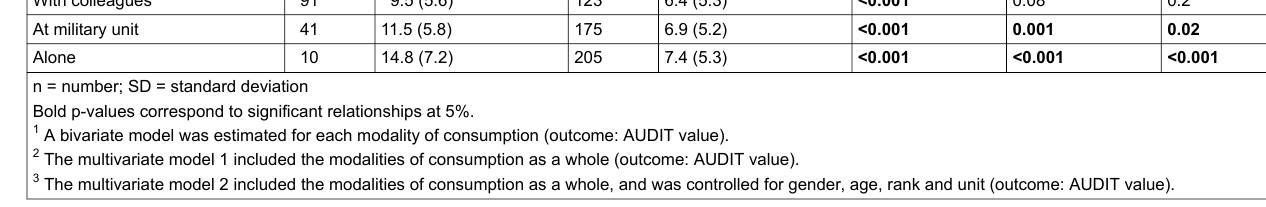
Table 2: Description of the 8 scales of the Alcohol Effects Questionnaire (AEFQ) and their internal coherence measured by the Cronbach α coefficient. Scale